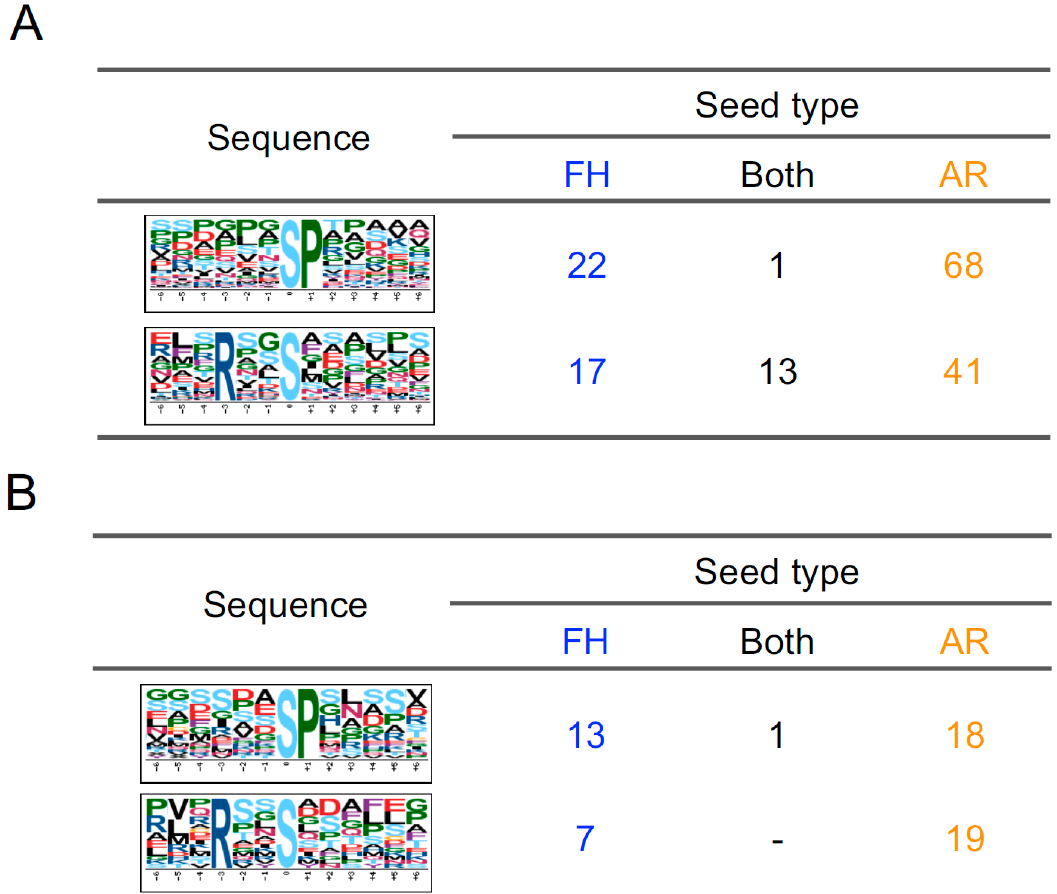
Figure 5. Motif analysis of phosphopeptides in barley grains. Motif analysis of 269 upregulated phosphopeptides ( A ) and 97 downregulated phosphopeptides ( B ) using the motif-x algorithm. Extracted phosphorylation motifs were counted in the data from FH or AR grains.